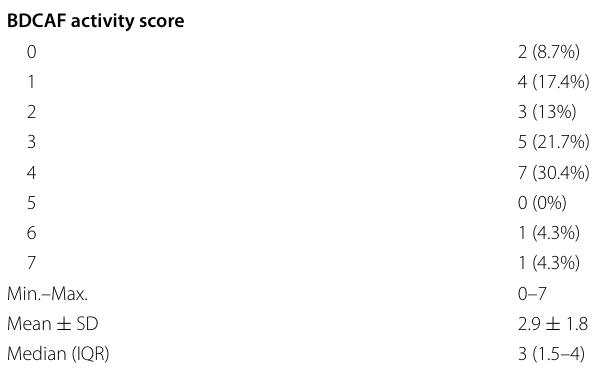
Table 1 Classification of patients according to BDCAF